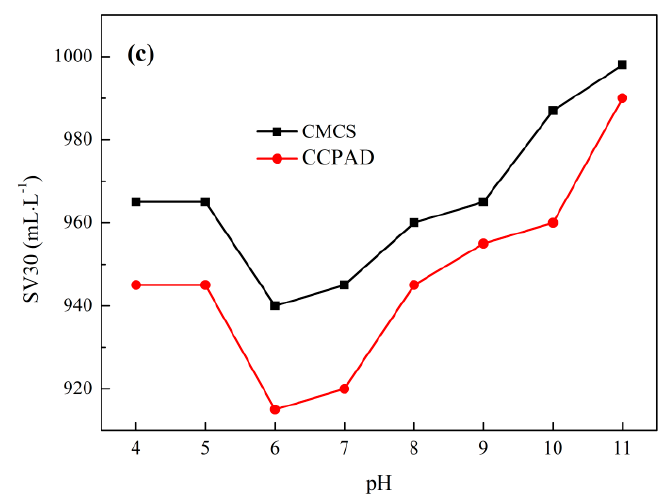
Figure 9. Sludge settleability: ( a ) cationic degree, ( b ) intrinsic viscosity, and ( c ) pH.